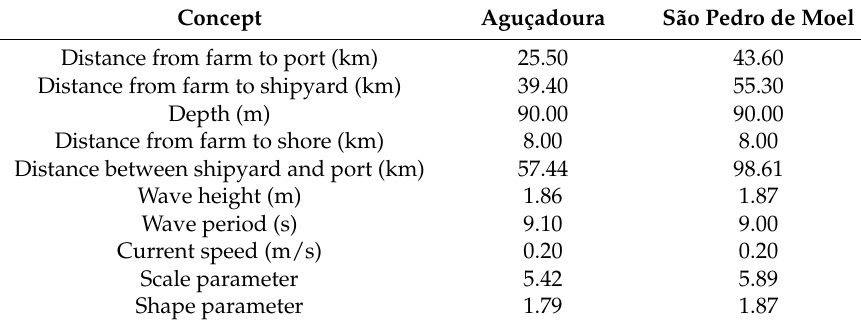
Table 4. Location parameters.